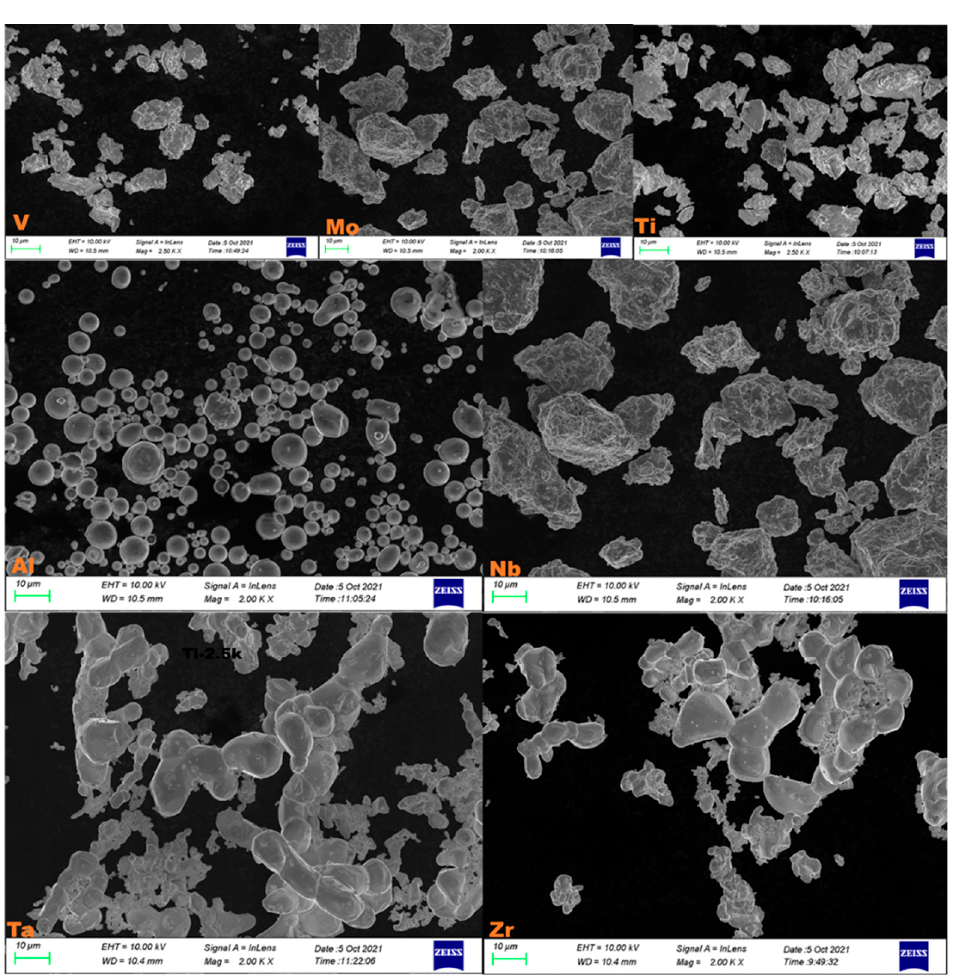
Figure 1. SEM images showing the microstructure of elemental powder .